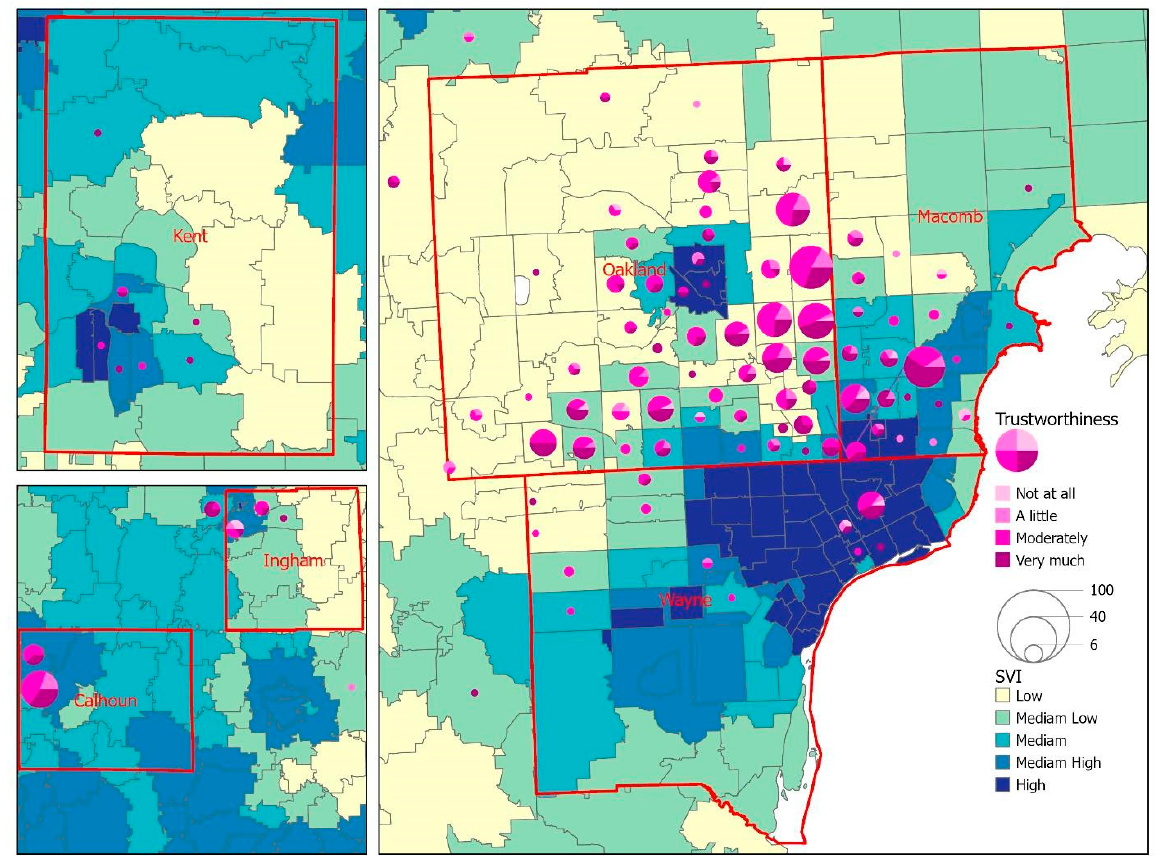
Figure 4. A map for the visualization of the overall SVI against the trust in public health agencies among survey respondents.